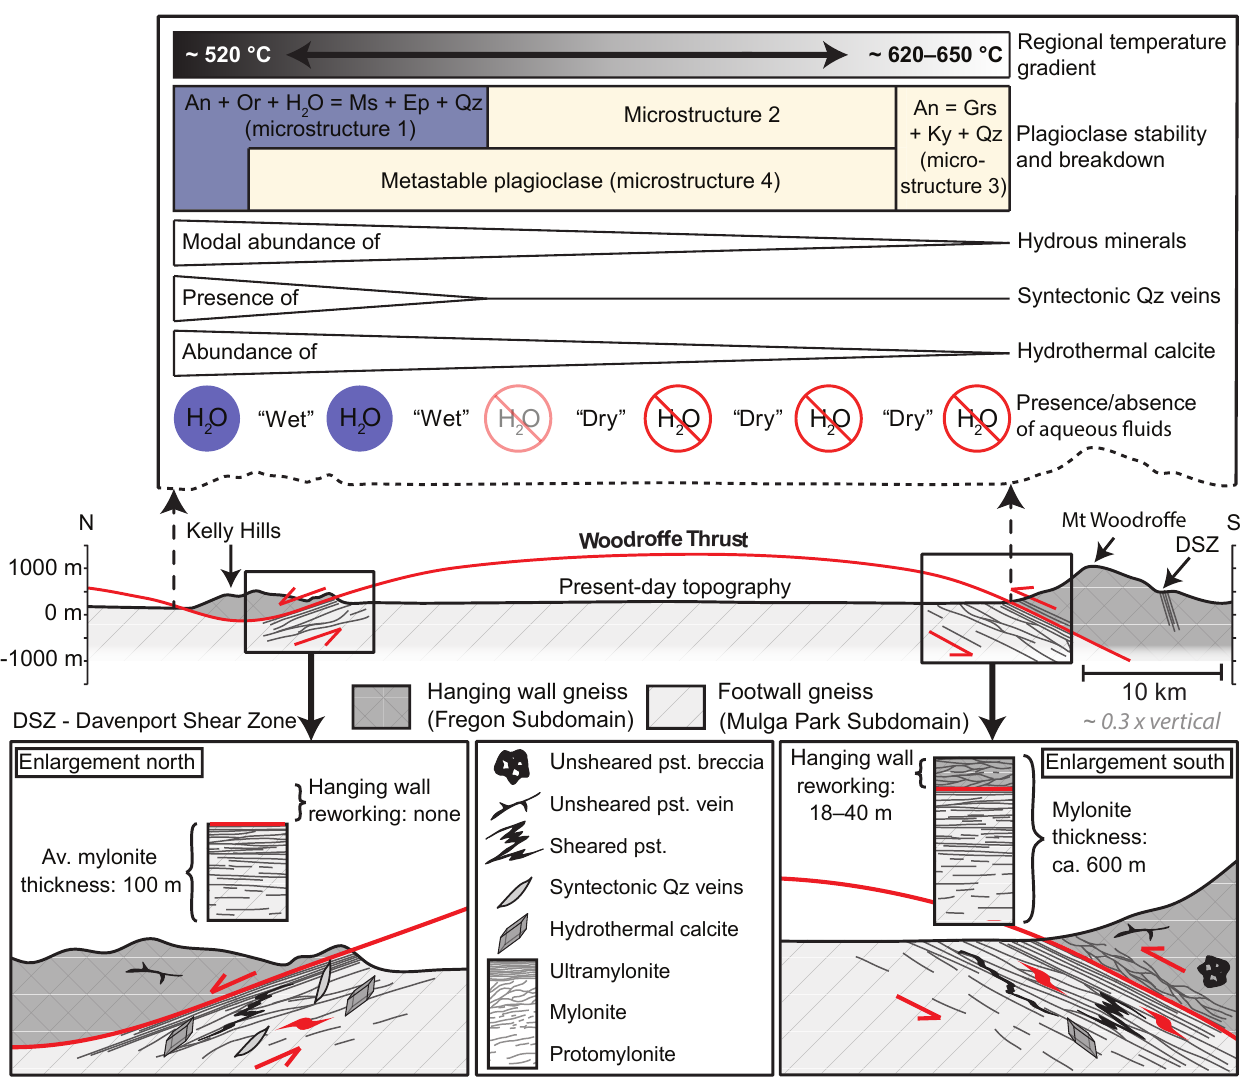
Figure 9. Projected schematic cross section through the central Musgrave Block. The horizontal scale is compressed by a factor of 3.5 with respect to the vertical scale. The regional temperature gradient is taken from Wex et al.